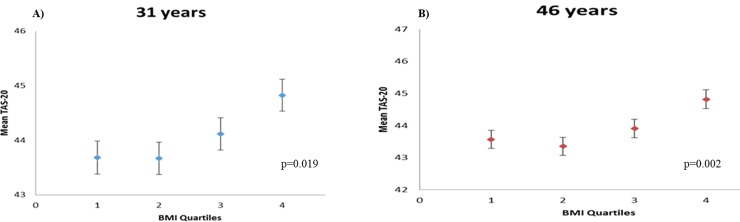
Cross-sectional analysis of TAS-20 scores and BMI at A) 31-year and B) 46-year time points in the NFBC1966. BMI was subdivided into quartiles at each time point measured; Q131y: 15.32–21.75 kg/m2, Q231y: 21.76–23.86 kg/m2, Q331y: 23.87–26.50 kg/m2, Q431y: 26.51–54.32 kg/m2, Q146y: 16.06–23.57 kg/m2, Q246y: 23.58–26.15 kg/m2, Q346y: 26.16–29.41 kg/m2 and Q446y: 29.42–73.81 kg/m2. Data presented are estimated marginal means (±SEM) derived from the model, adjusted for sex and socio-economic status (marital status, education level, employment status and annual income).